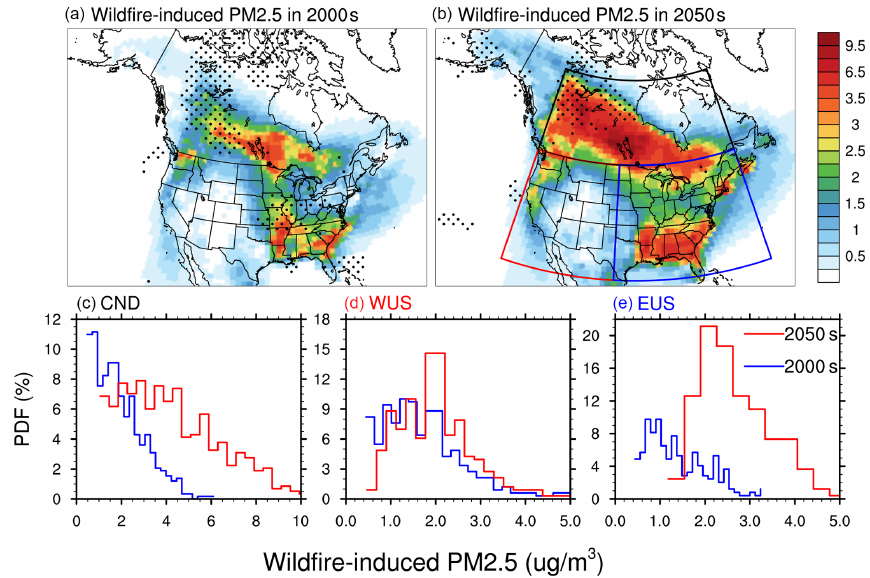
Figure 3. Spatial distribution of PM 2 . 5 concentrations. Spatial distribution of decadal-mean wildfire-induced enhancement in summer (JJA) PM 2 . 5 concentration over North America for the present day (2000 ALL -2000 WEF ) (a) and the future (2050 ALL –2050 WEF ) (b) . The grids with statistical significance of 90% are identified by black dots. (c–e) Probability density functions (PDFs) of wildfire contribution within the three regions shown in Fig. 2b for Canada (CND: black box) (c) , the WUS (red box) (d) , and the EUS (blue box) (e) , respectively, for the 2000s (blue) and the 2050s (red). Only grids over land in North America are used to generate the PDFs. The y axis indicates the probability of occurrence of different PM 2 . 5 values shown on the x axis. The color bar illustrates PM 2 . 5 in micrograms per cubic